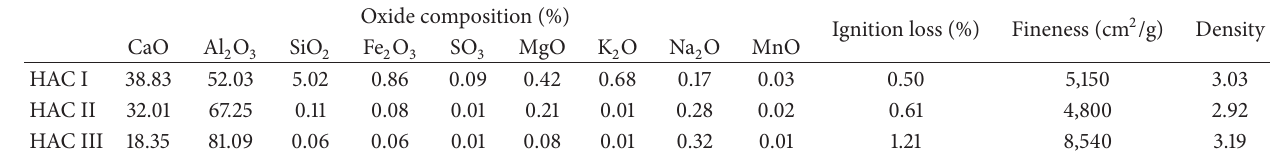
Table 1: Oxide composition and chemical properties of different HAC